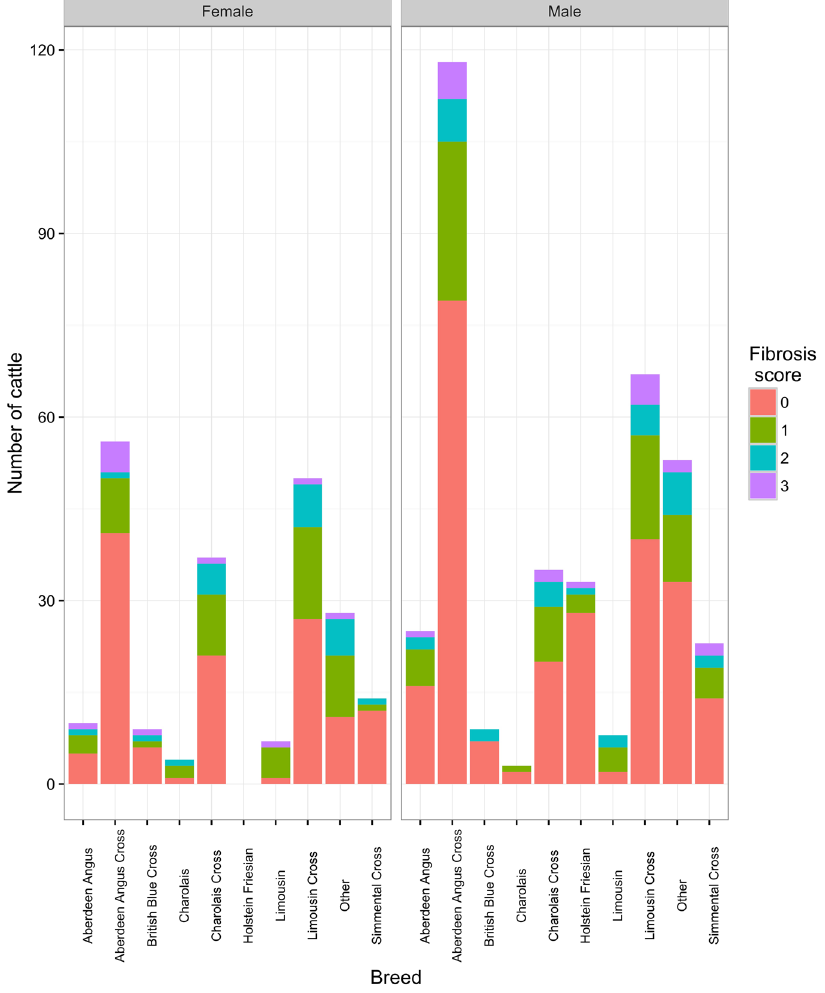
Figure 5. Distribution of fibrosis scores by cattle breed and sex. Figure shows the distribution of fibrosis scores according to sex and breed of sampled